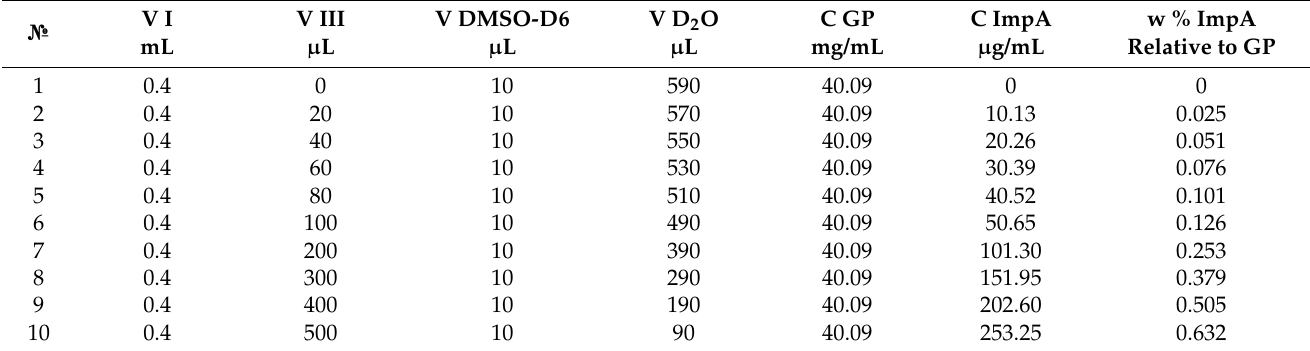
Table 6. Preparation of model solutions of GP and ImpA